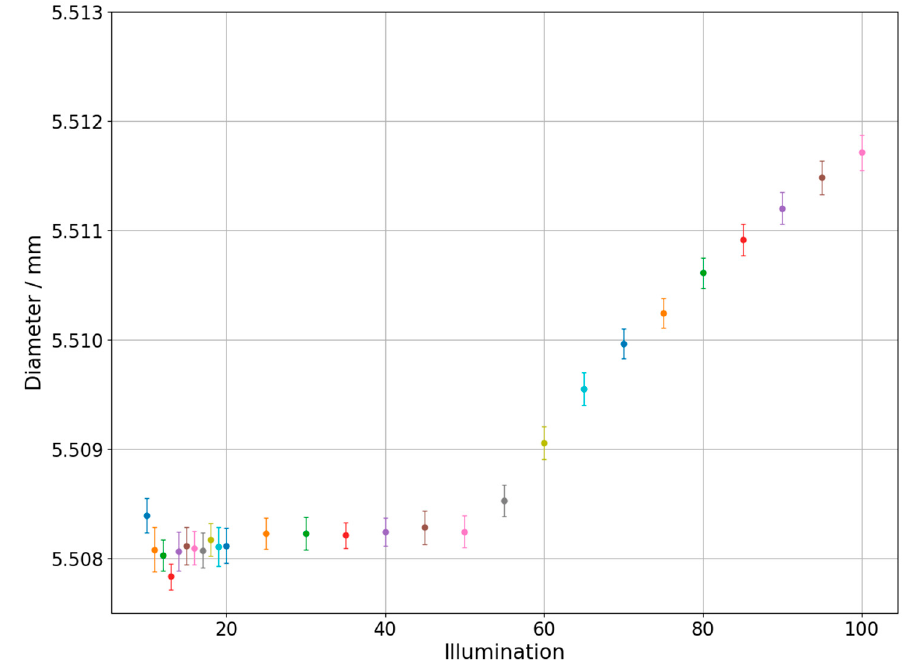
Figure 4. Diameter changes depending on the applied backlight. Hole plate standard measurement.